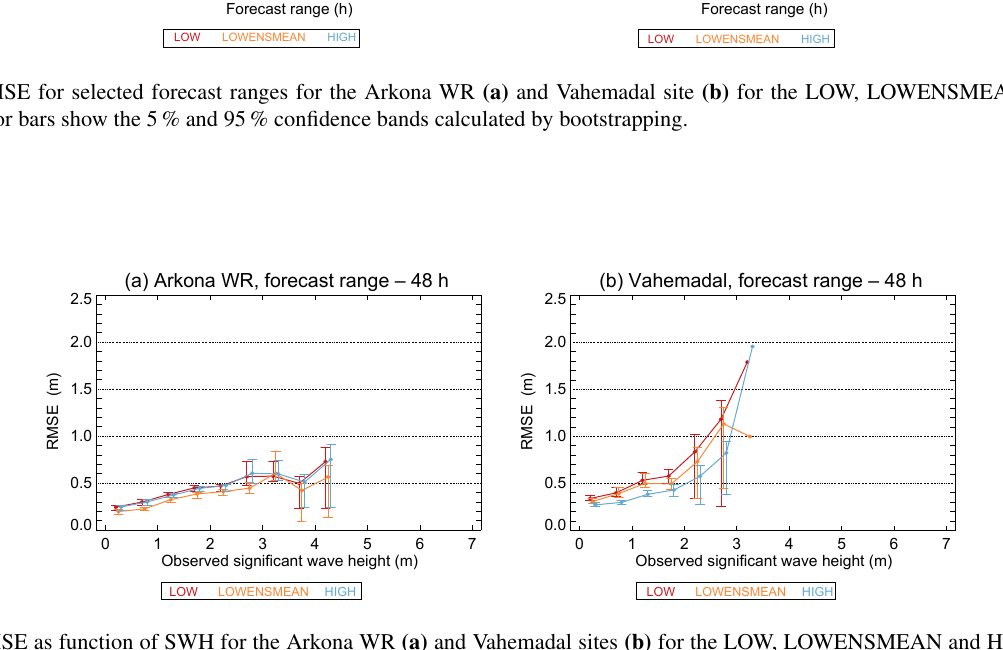
Figure 8. RMSE as function of SWH for the Arkona WR (a) and Vahemadal sites (b) for the LOW, LOWENSMEAN and HIGH forecasts with a forecast range of 48h. Error bars show the 5% and 95% confidence bands calculated by bootstrapping.